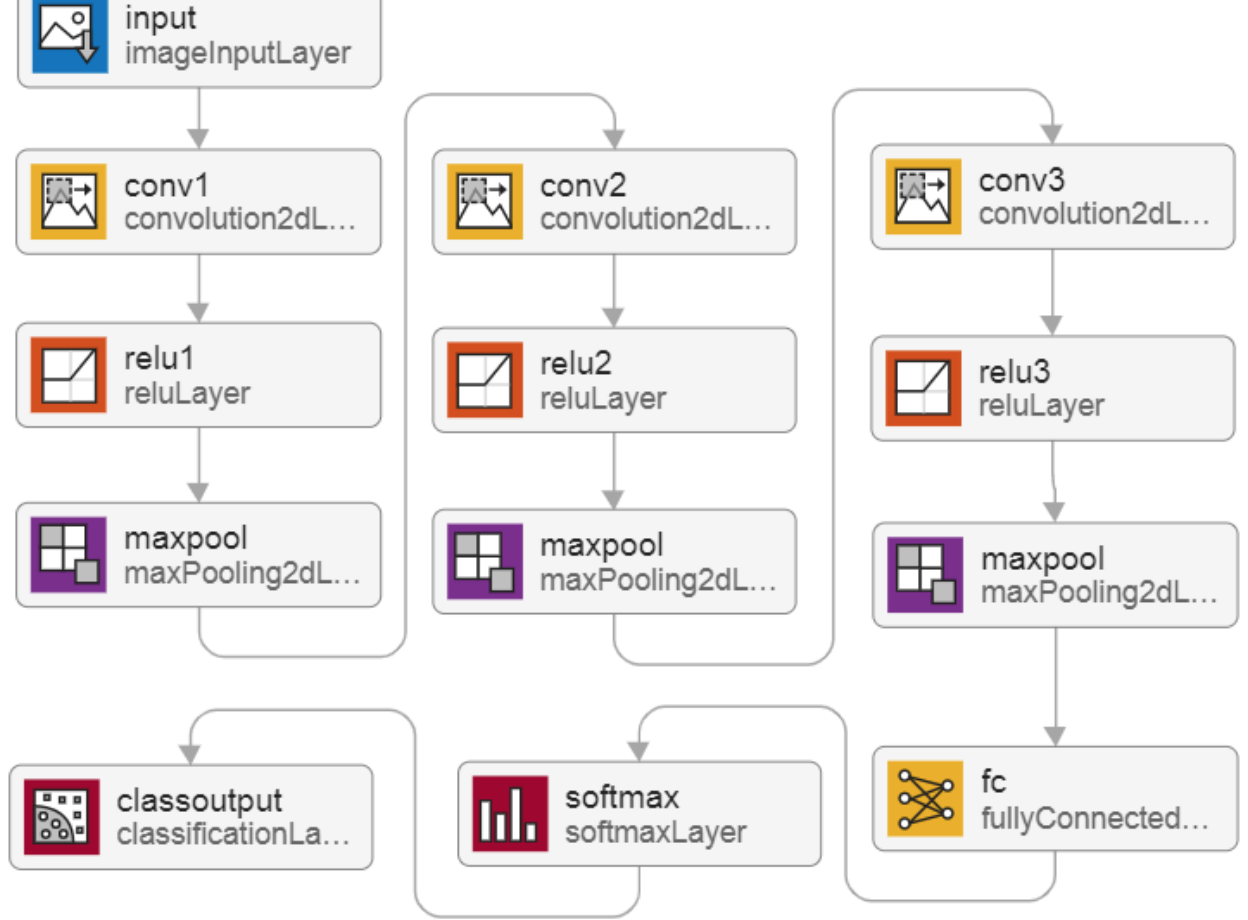
Figure 11. The 13-layer DNN architecture for the FTL method.